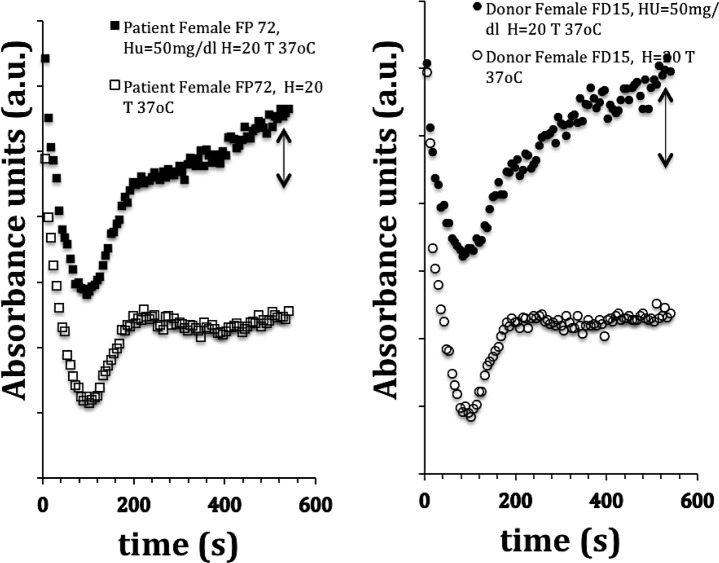
(a) and (b): Alterations of the Rigidity Index (Ri) of female patient (a) and a female donor (b) blood sample (Hct = 20, essay temperature: 37°C) with the in vitro addition of hydroxyurea (HU) at a concentration of 50mg /ml. Ri value for patient FP72 without HU: 8.6; RI value with HU: 25.9 (p <0.001); Ri value for donor FD15 without HU: 5.7; RI value with HU: 166.7 (p <0.001). Values are the mean of three essays of the female patient FP72 and two essays for the female donor FD15 both with and without addition of HU, hematocrit adjusted for Hct = 20(0,2l/l), patient age: 13 y.o and Hb: 6.8 g/l; donor age: 47, Hb: 13.1 g /l, Test temperature: 37°C.